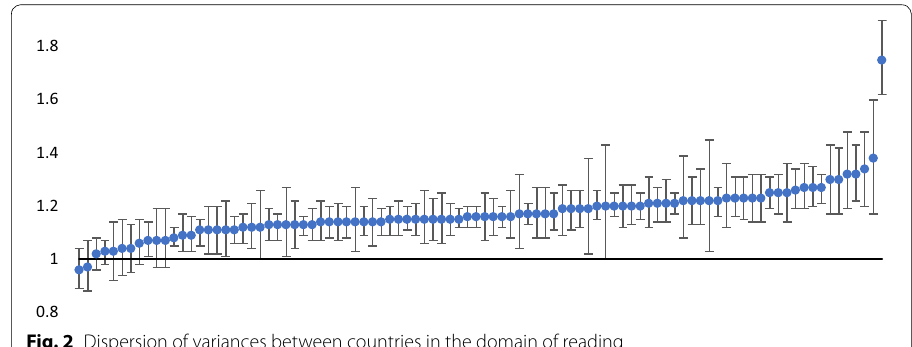
Fig. 2 Dispersion of variances between countries in the domain of